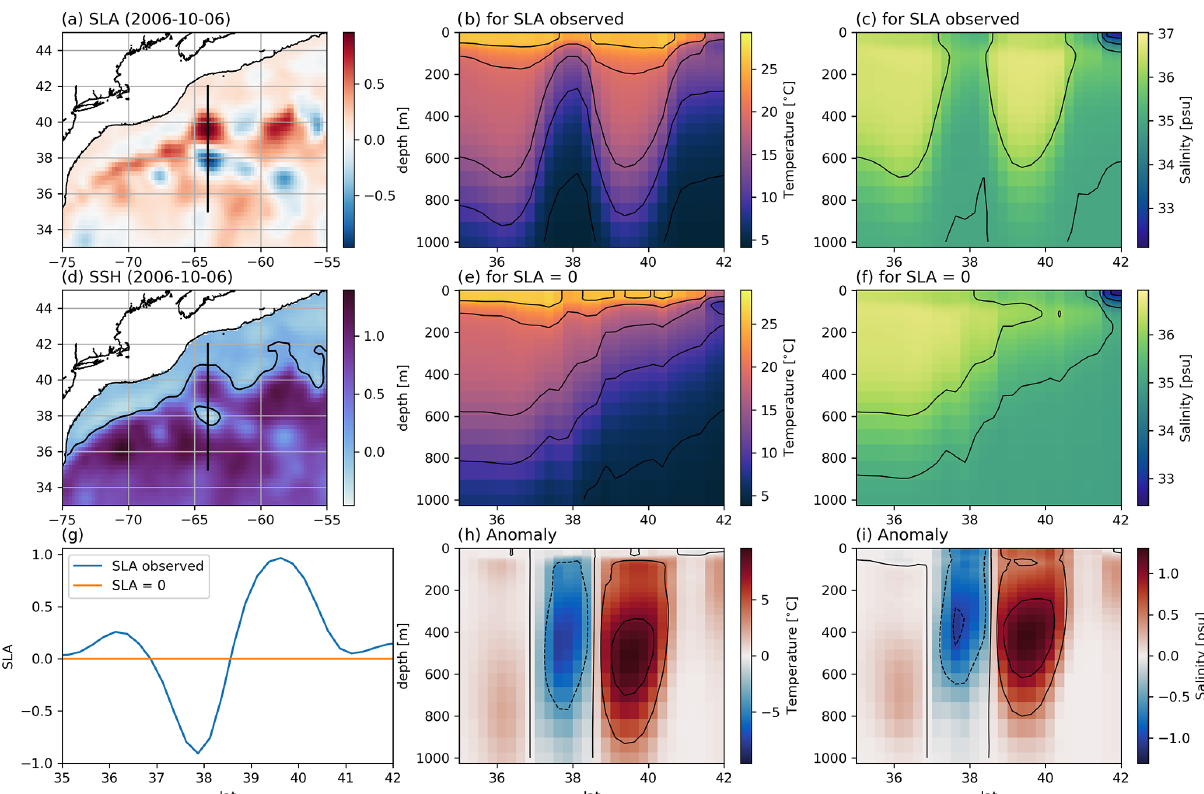
Figure 16. Prediction of T − S profiles for a section across two meanders of the Gulf Stream (b, c) and for a simulated SLA flattened to zero (e, f) . The meanders are visualized with maps of SLA (a) and SSH d , which are computed by adding MDT and SLA for 6 October 2006. The anomaly between the T − S sections for the observed SLA and the simulated SLA is displayed in panels (h) and (i) . The SSH contour in panel (d) is 0.1m to represent the Gulf